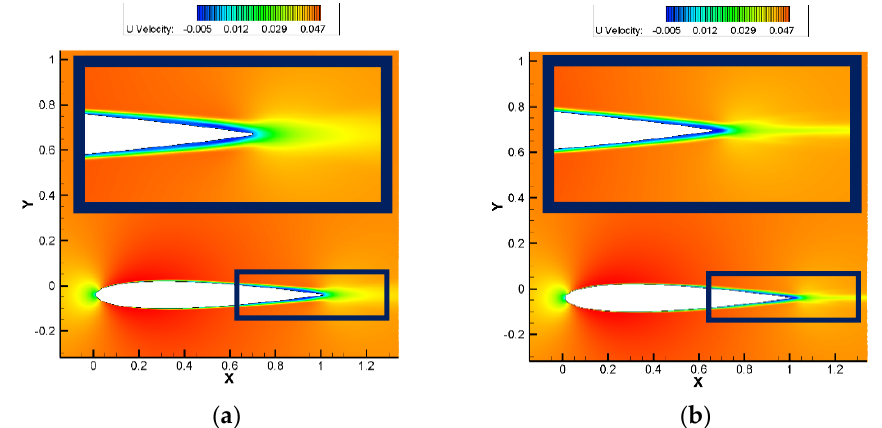
Figure 14. Time-averaged U-velocity contours in 2D ( a ) and 3D ILES ( b ). Baseline case for NACA- 0012 at 0° AoA and U = 16 m/s. [18]. Appl. Sci. 2021 , 10 , x FOR PEER REVIEW